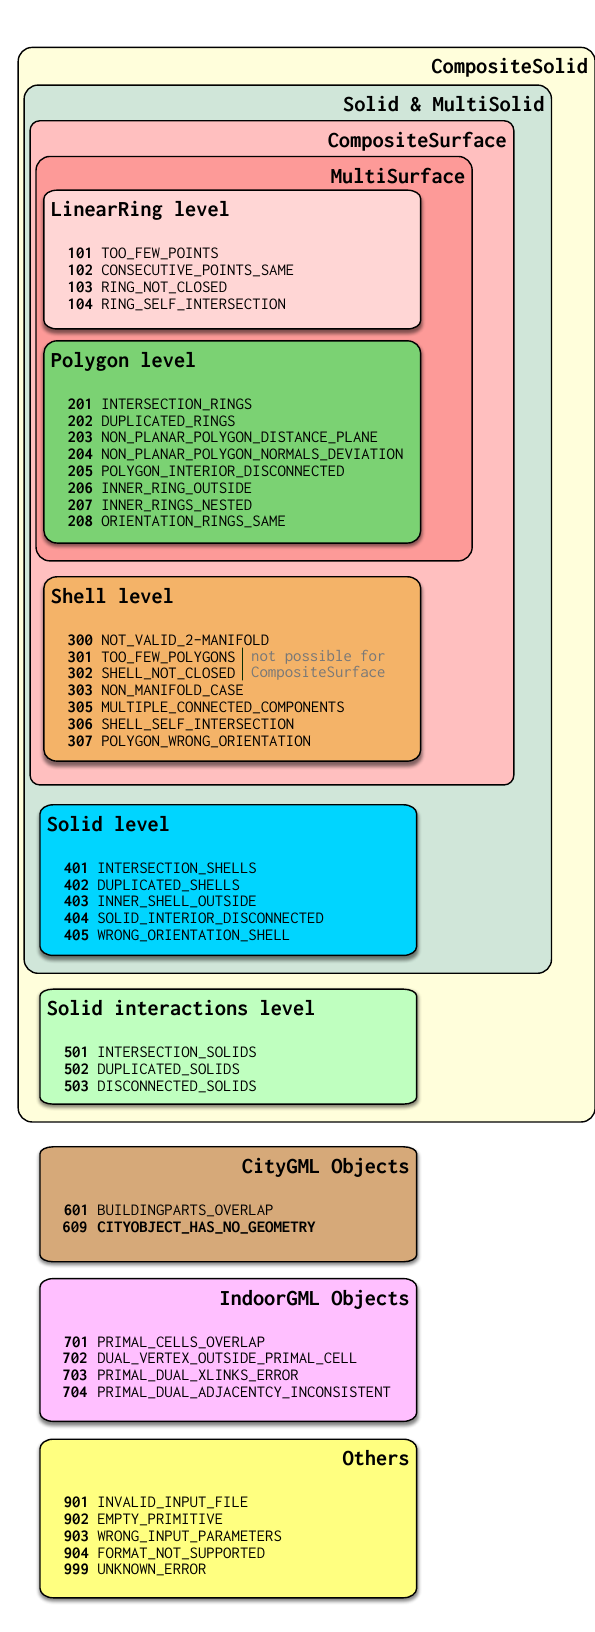
Figure 6. The 37 error codes of